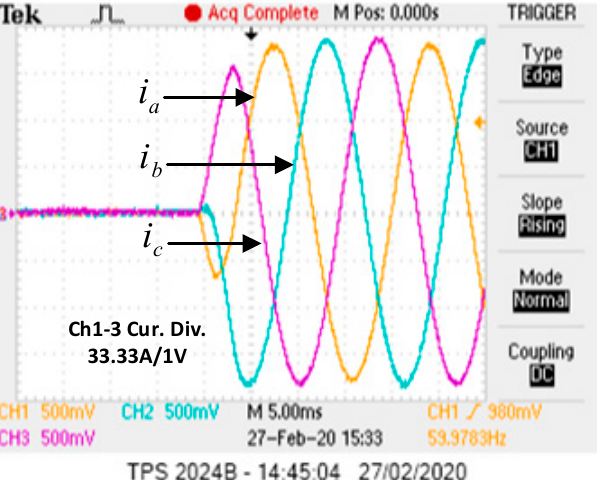
Figure 6. Three-phase output current during initialization from Pref = 0 to Pref = 10 kW and Qref = 0 kVAr.